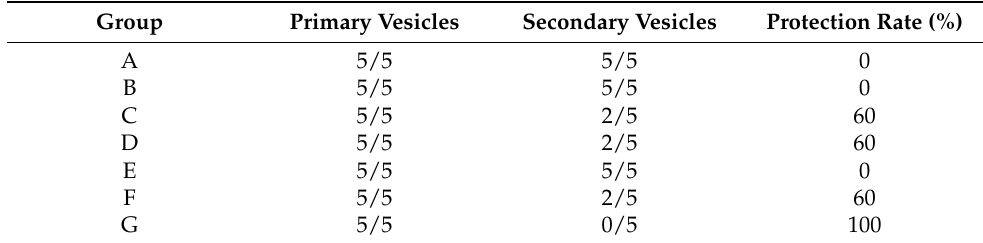
Table 6. Protection rates in guinea pigs after 100 GPID 50 FMDV serotype A